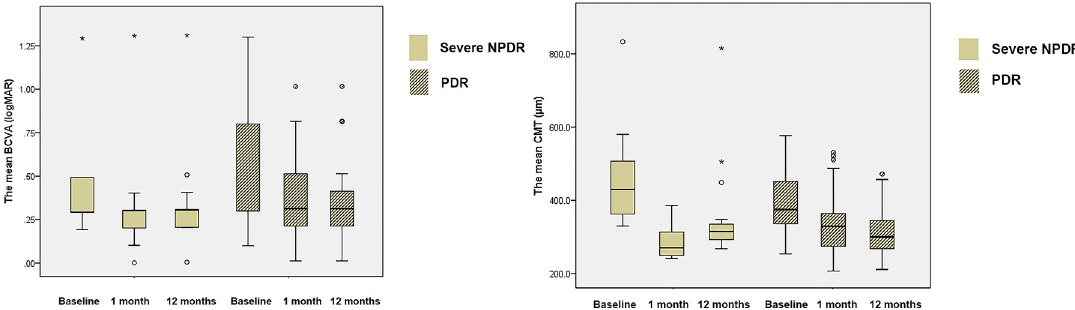
Fig 2. The changes of mean best-corrected visual acuity (BCVA) and mean central macular thickness (CMT) the patients with severe nonproliferative diabetic retinopathy (DR) and proliferative DR. (A) The mean BCVA was 0.5 ± 0.4 (1.3~0.2) logMAR in the severe nonproliferative DR group, and 0.6 ± 0.4 (1.3~0.1) logMAR in the proliferative DR group (P = 0.315). Mean BCVA was significantly improved at 1 month and 12 months after intravitreal injection, compared with baseline (P < 0.001 for both). (B) Mean CMT was also significantly reduced at 1 month and 12 months after intravitreal injection, compared with baseline (P < 0.001 for both). At each follow-up point, the mean BCVA (P = 0.667 at 1 month, P = 0.907 at 12 months) and the mean CMT (P = 0.432 at 1 month, P = 0.182 at 12 months) were not significantly different between the patients with severe nonproliferative DR and proliferative